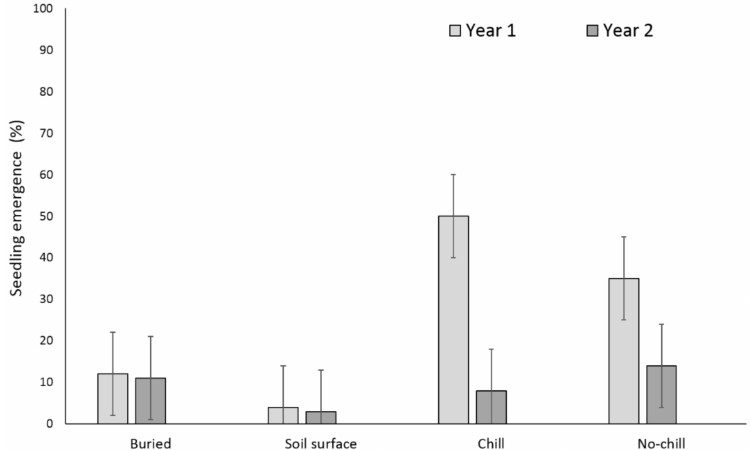
Figure 6. Effect of environmental conditions on S. obtusifolia emergence originating from a multiple maternal source. Vertical bars represent LSD at 5% significance